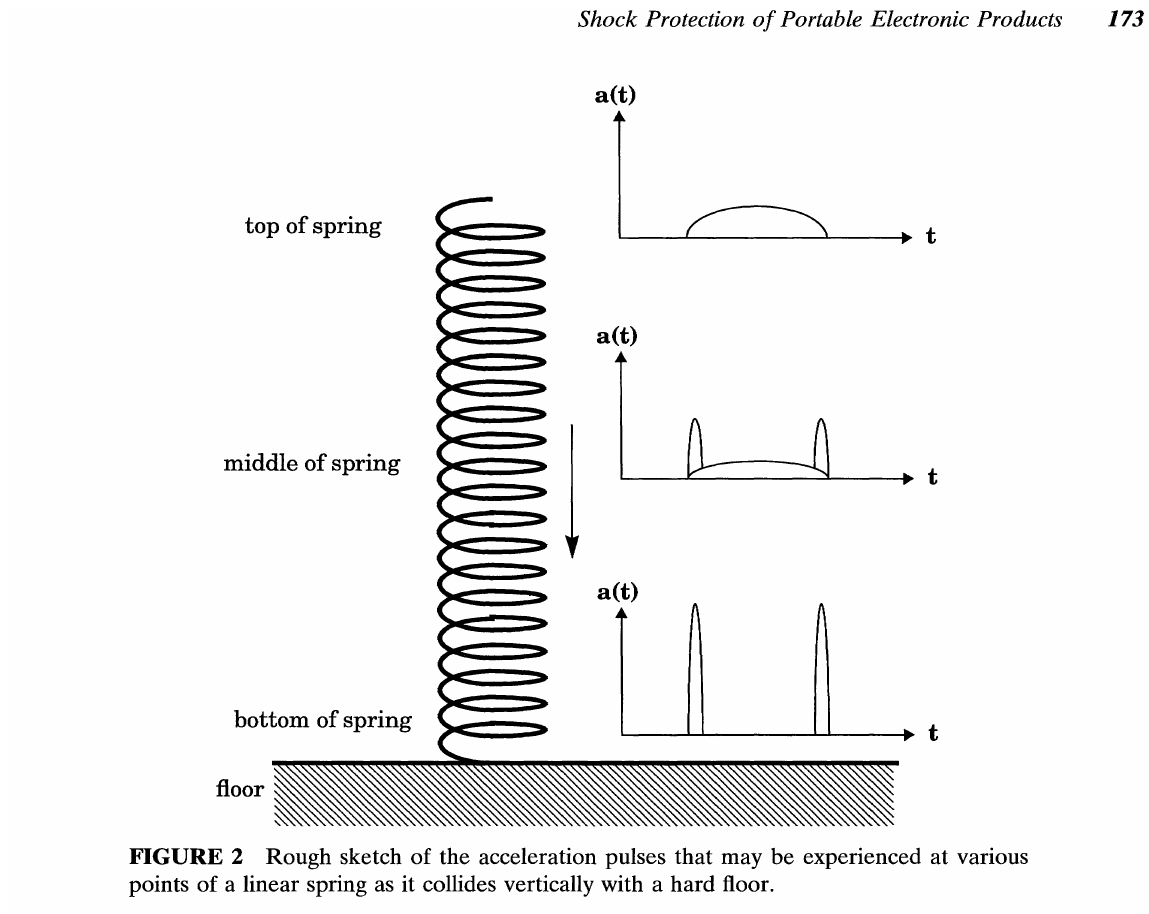
FIGURE 2 Rough sketch of the acceleration pulses that may be experienced at various points of a linear spring as it collides vertically with a hard